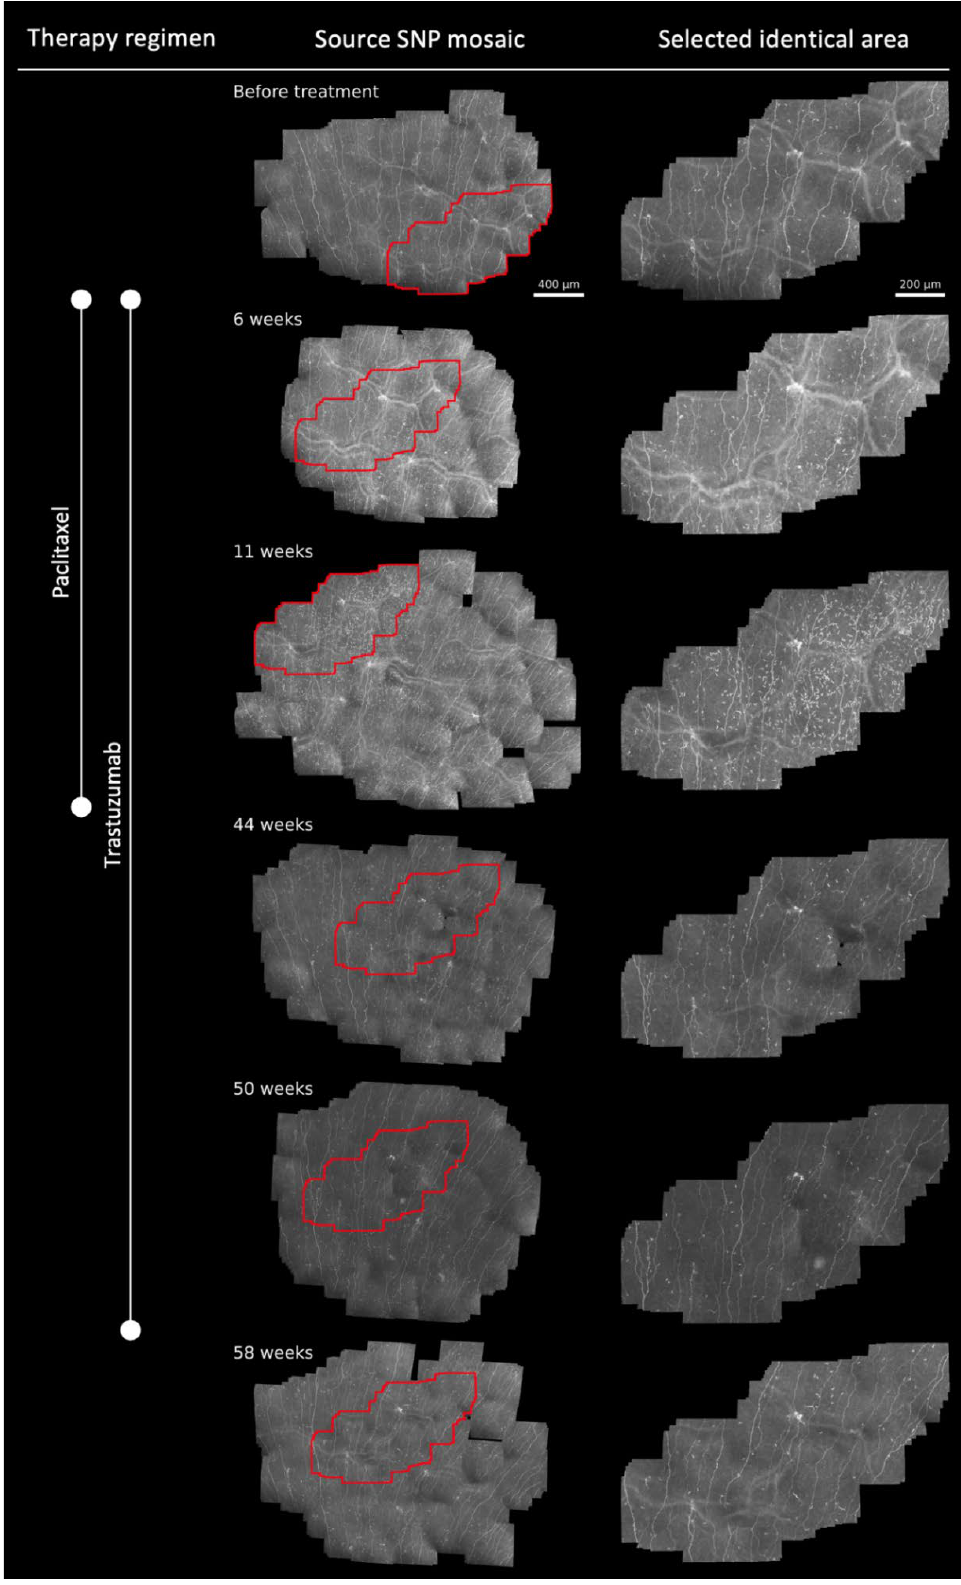
Figure 1. In vivo large-area confocal laser scanning microscopy (CLSM) of the corneal subbasal nerve plexus (SNP) of a breast cancer patient (human epidermal growth factor receptor (HER)-2-positive) at baseline, during, and after paclitaxel and trastuzumab therapy regimen. The detailed